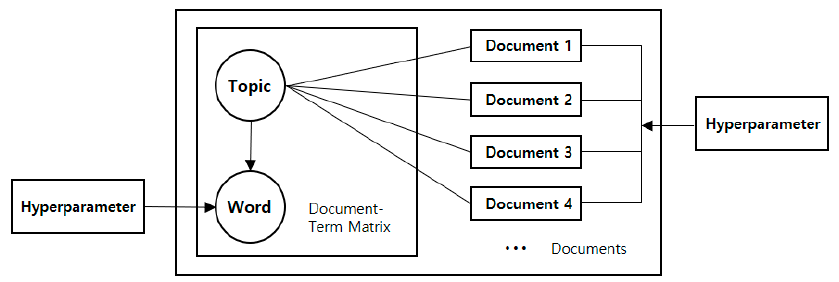
Figure 1. LDA topic generation.